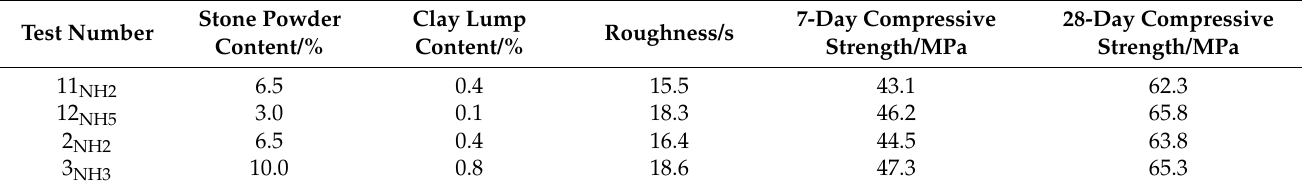
Table 12. Performance indicators and experimental results of high-quality fine